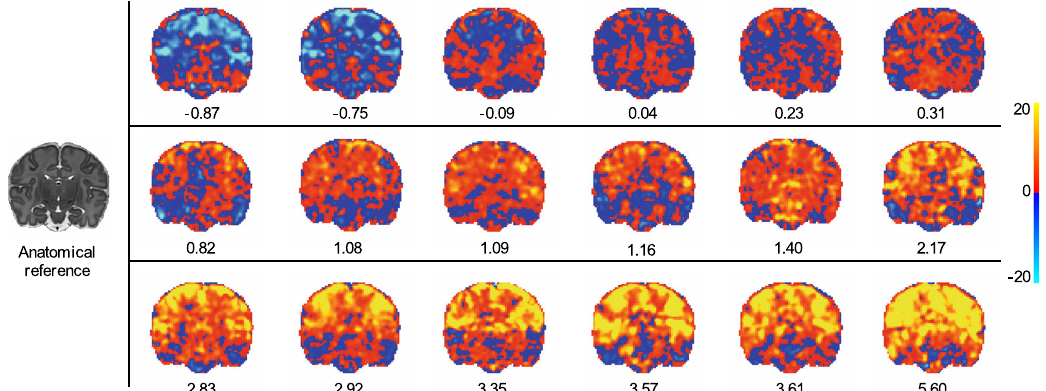
Fig. 1 Noxious-evoked response amplitudes. A noxious-evoked response BOLD activity map is presented for each neonate ( n = 18) and ordered according to the overall response amplitude. The maps are general linear model regression parameter maps (regression parameters are scaled according to colour bar). The anatomical reference (left) provides structural detail for orientation. All maps are displayed at this slice position to maximally emphasise the range of individual variability in response amplitudes. Unthresholded maps are used for visualisation to demonstrate the range of evoked response amplitudes from negative to negligible to positive amplitudes, without introducing the issues inherent to the application of arbitrary thresholds. The scalar value presented below each map is a summary measure that represents the overall noxious-evoked response amplitude relative to the group average. Source data are provided as a Source Data fi